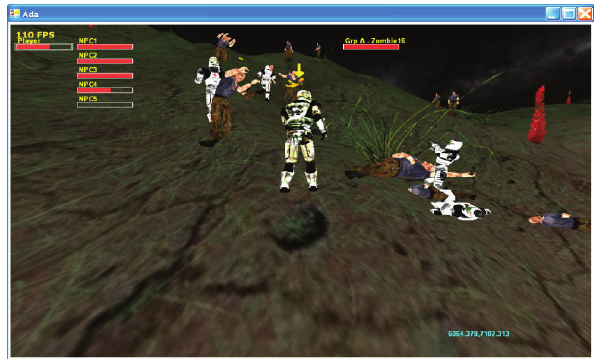
Figure 4: A screenshot of the fundamental TAP experimental game environment. The game represents a typical FPS setting. The PC is in the center, and each of the other NPCs in white are busy with their own tasks chosen. The opponents are the zombies scattered over the map in packs.